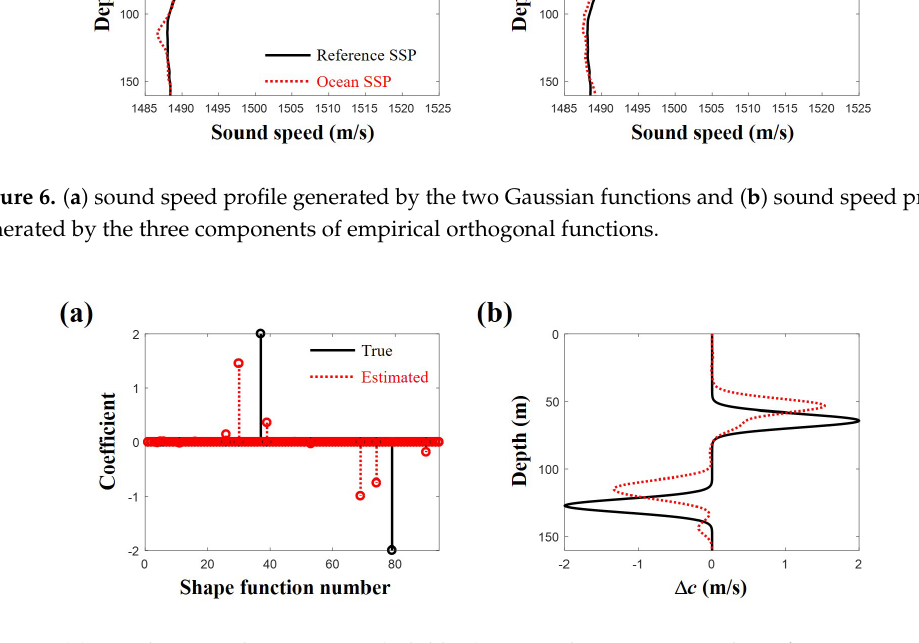
Figure 7. ( a ) actual activated components (solid line) among the 94 Gaussian shape functions in sound speed profile dictionary and estimated components (dotted line) from the compressive sound speed profile estimation; ( b ) the sound speed differences along depth from the reference sound speed profile. The solid and dotted lines are actual and reconstructed values,